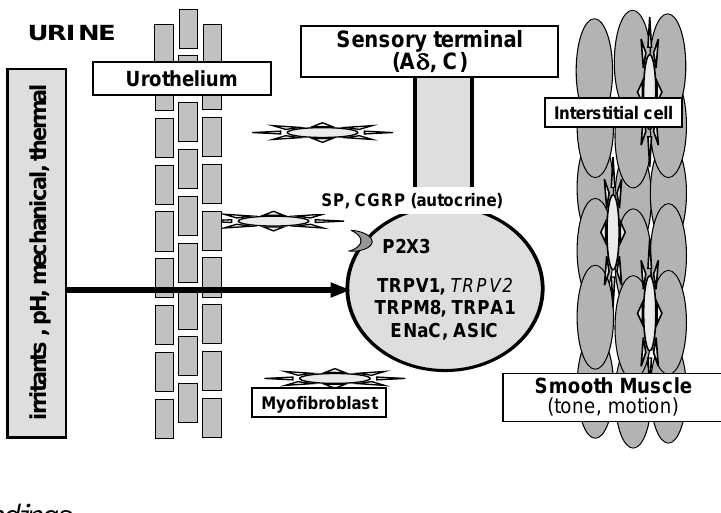
Figure 2. Possible roles of nociceptive ion channels in direct activation of suburothelial sensory nerve terminals. Italic letter indicates ion channels with weak evidence for functional